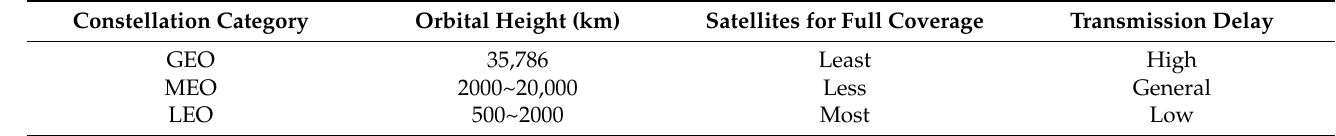
Table 1. Constellation networking features.